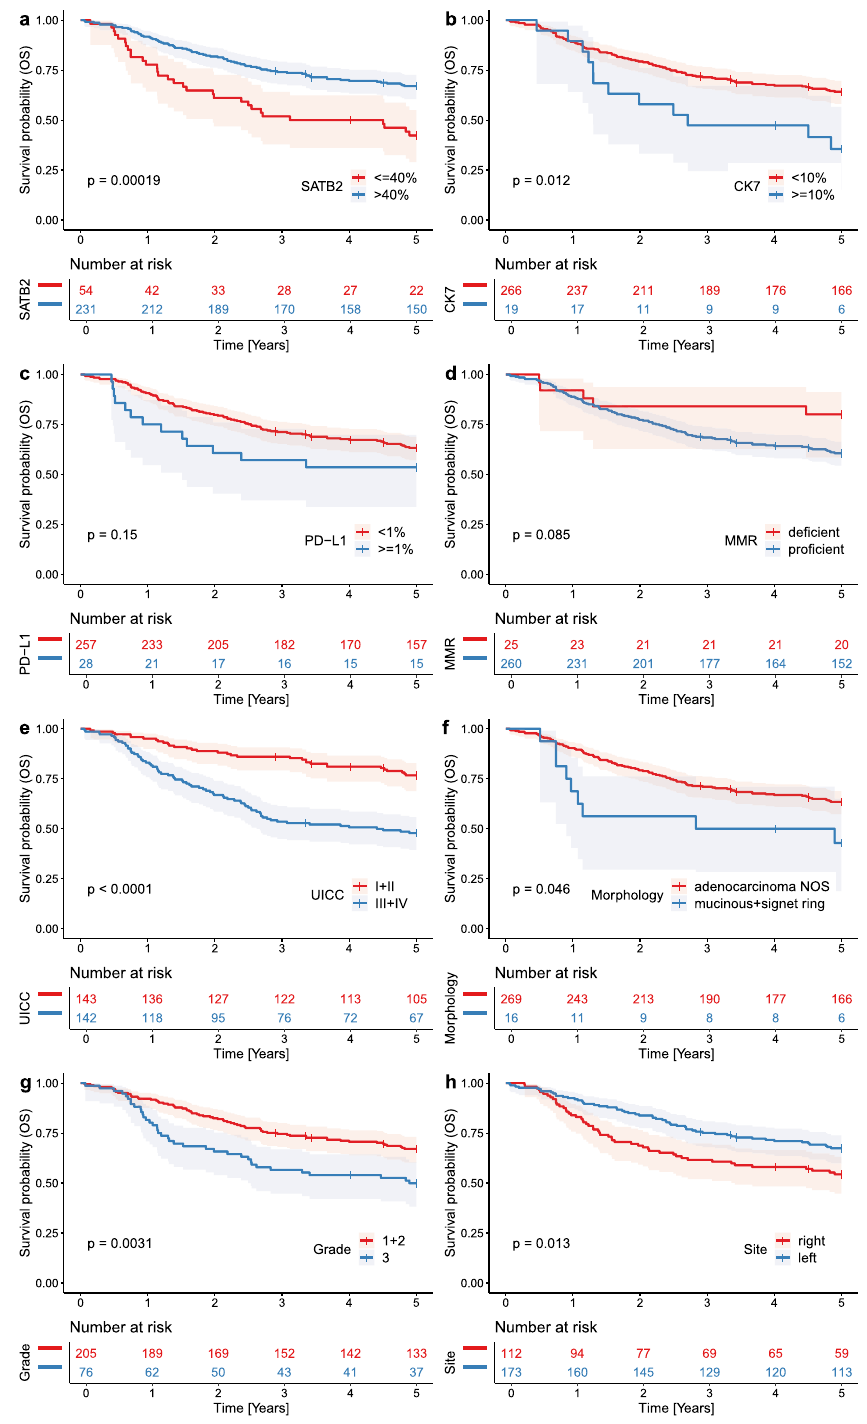
Figure 2. Entire cohort, Kaplan Meier curves documenting 5-year overall survival (OS) in patients with CRC. Note decreased survival in patients with CRC with SATB2 low expression ( a ), CK7 high expression ( b ), PD-L1 expression ( c ), mismatch-repair proficient status ( d ), advanced stage ( e ), mucinous or signet ring cell morphology ( f ), high-grade tumors ( g ), and right-sided tumor localization ( h ). P values from the log-rank test < 0.05 indicate a significant difference in